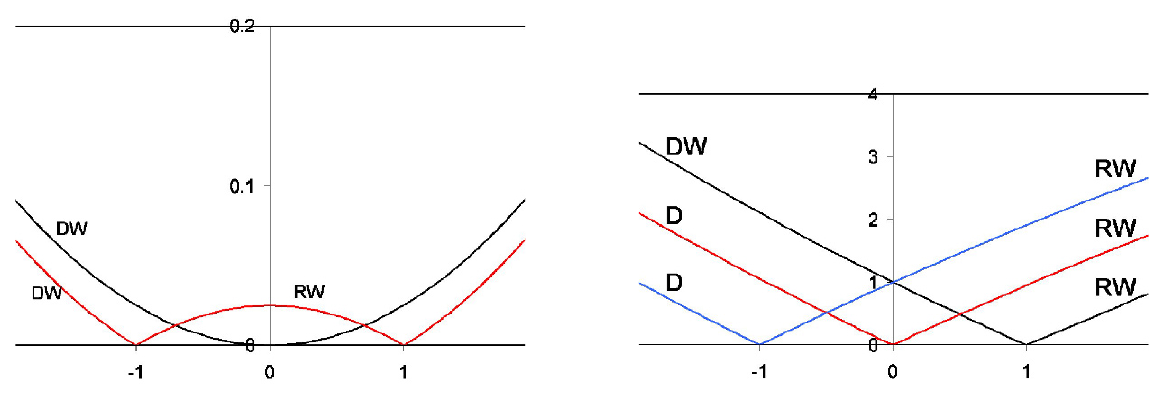
Figure 1. Wavefronts for explosions at x = 0 and y = 20 m (left) and x = y = 20 m